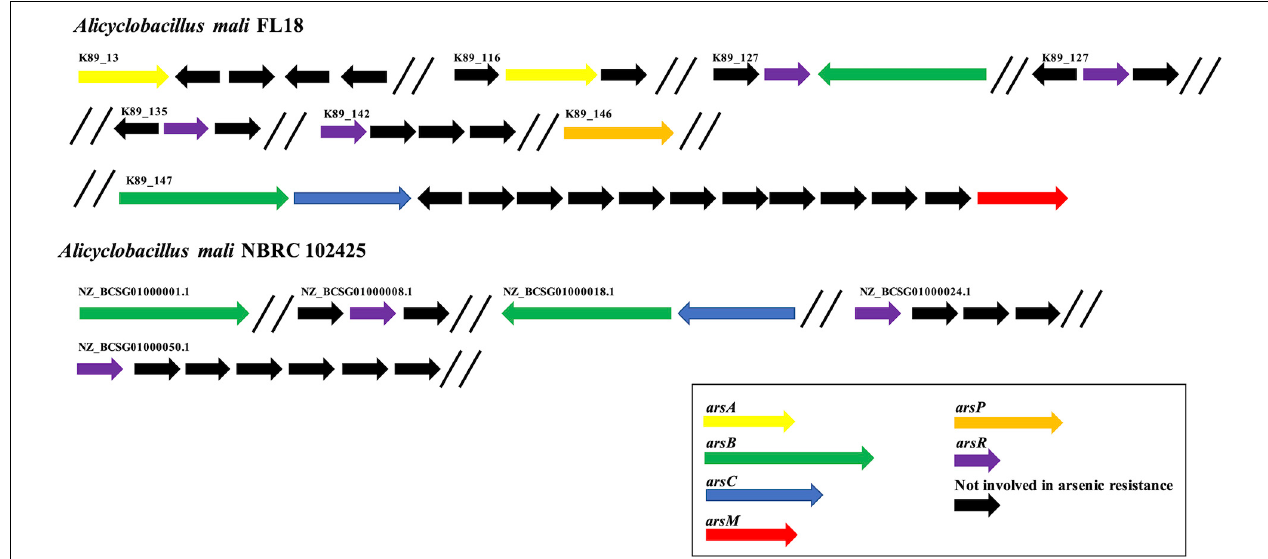
FIGURE 6 | Organization of arsenic resistance genes. Comparison of arsenic resistance genes in A. mali FL18 (Up) and A. mali NBRC 102425 (Down) . In purple, arsR genes coding for arsenic responsive transcriptional regulator; in blue, arsC genes coding for arsenate reductase; in green, arsB genes coding for arsenite membrane transporter; in yellow, arsA genes coding for anion stimulated ATPase; in red, arsM genes coding for arsenite methyltransferase; in orange, arsP genes coding for organoarsenical permease; in black, genes that are not involved in arsenic resistance.